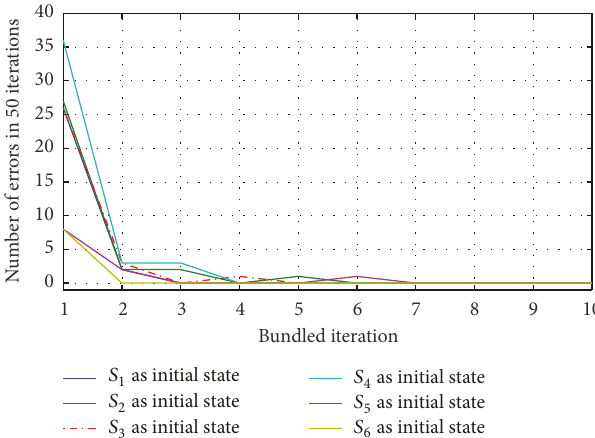
Figure 5: Error in iterations bundled in 50 for different runs with different initial